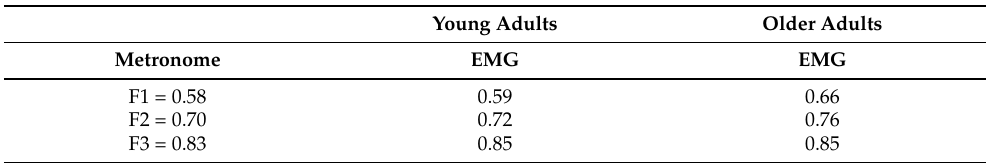
Table 6. The frequency strides estimated for both subject groups are reported and compared with the metronome frequencies (F1, F2 and